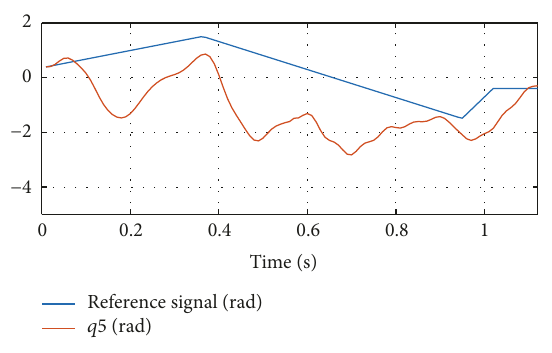
Figure 18: Trajectory of 𝑞 5